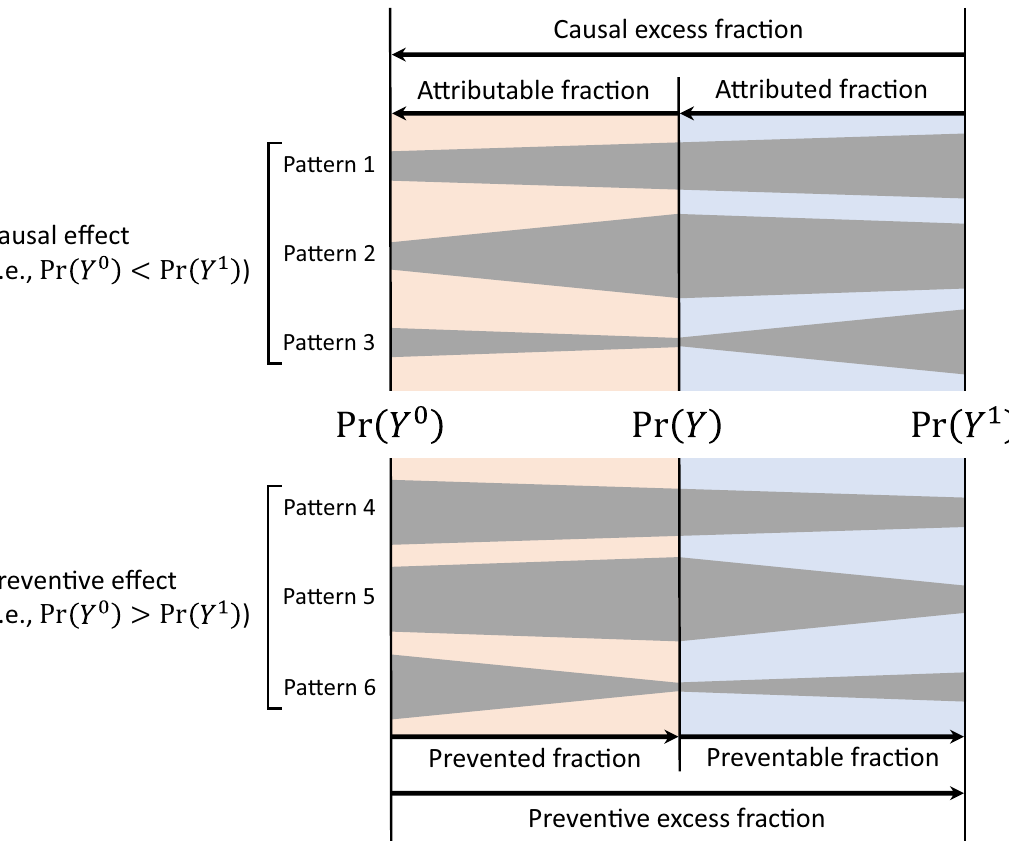
Figure 1: Conceptual schema of the six measures and six possible patterns. We show a schema when the target population is the total population. The six arrows show the contrasts of interest in the corresponding six measures. The arrow tails represent the reference points, whereas the arrow heads represent the points to be compared. The height of the gray areas represents the risk of the outcome for each pattern. We assume that Pr ( Y ) , Pr ( Y 0 ) , and Pr ( Y 1 ) all di ff er. Note that we conveniently describe their relationships in a linear manner. The di ff erence between Pr ( Y ) and Pr ( Y 0 ) represents the presence of either causal or preventive causation in the exposed group ( highlighted in light red ) , whereas the di ff erence between Pr ( Y ) and Pr ( Y 1 ) represents the presence of either causal or preventive causation in the unexposed group ( highlighted in light blue ) . For example, the attributable fraction ( population ) is a positive value in Patterns 1, 2, and 5 because Pr ( Y ) ( i.e., the reference point ) is higher than Pr ( Y 0 ) ( i.e., the point to be compared ) . In these patterns, the causal e ff ect is present in the exposed group and SMR is higher than 1. However, in Pattern 5, there is a preventive e ff ect in the total population. An analogous discussion applies to the attributed fraction, preventable fraction, and prevented